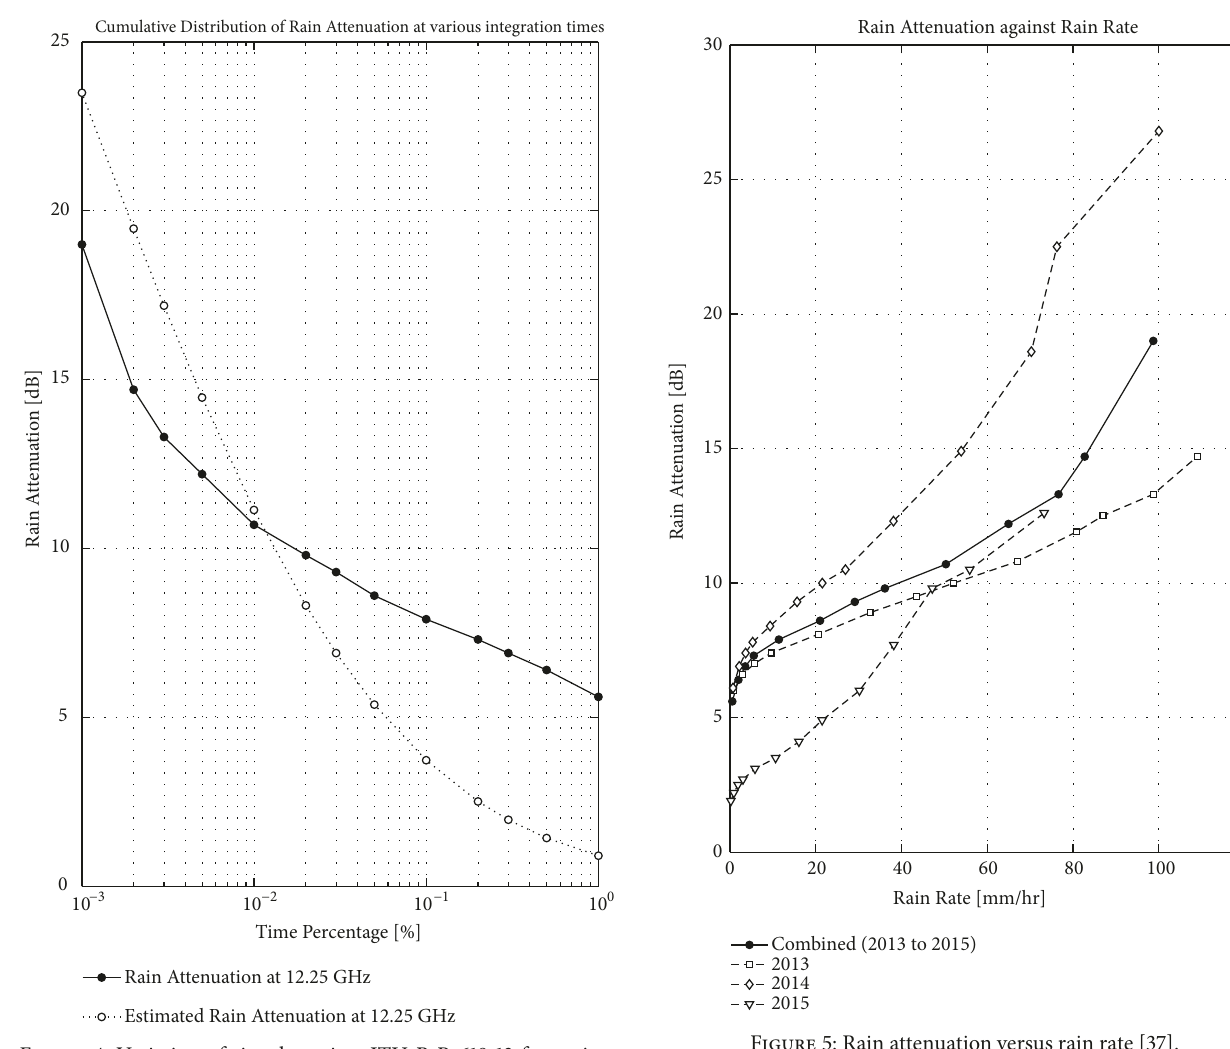
Figure 4: Variation of signals against ITU-R P. 618-13 for various integration times [37].